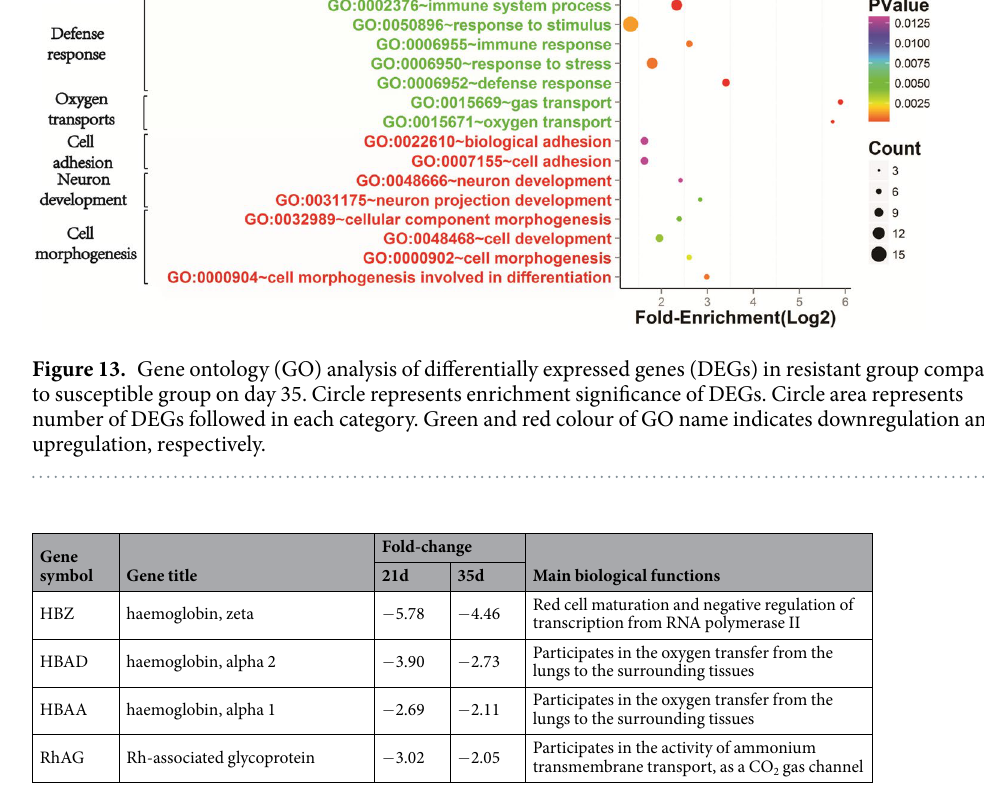
Table 3. The DEGs related to oxygen transport in the resistant group compared to susceptible group on day 21 and 35. Fold-changes represent relative gene expression